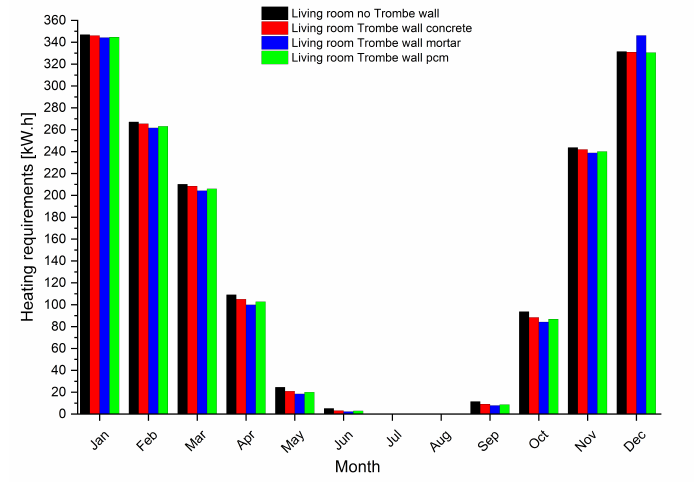
Figure 22. Comparison of monthly heating energy demands in the living room.